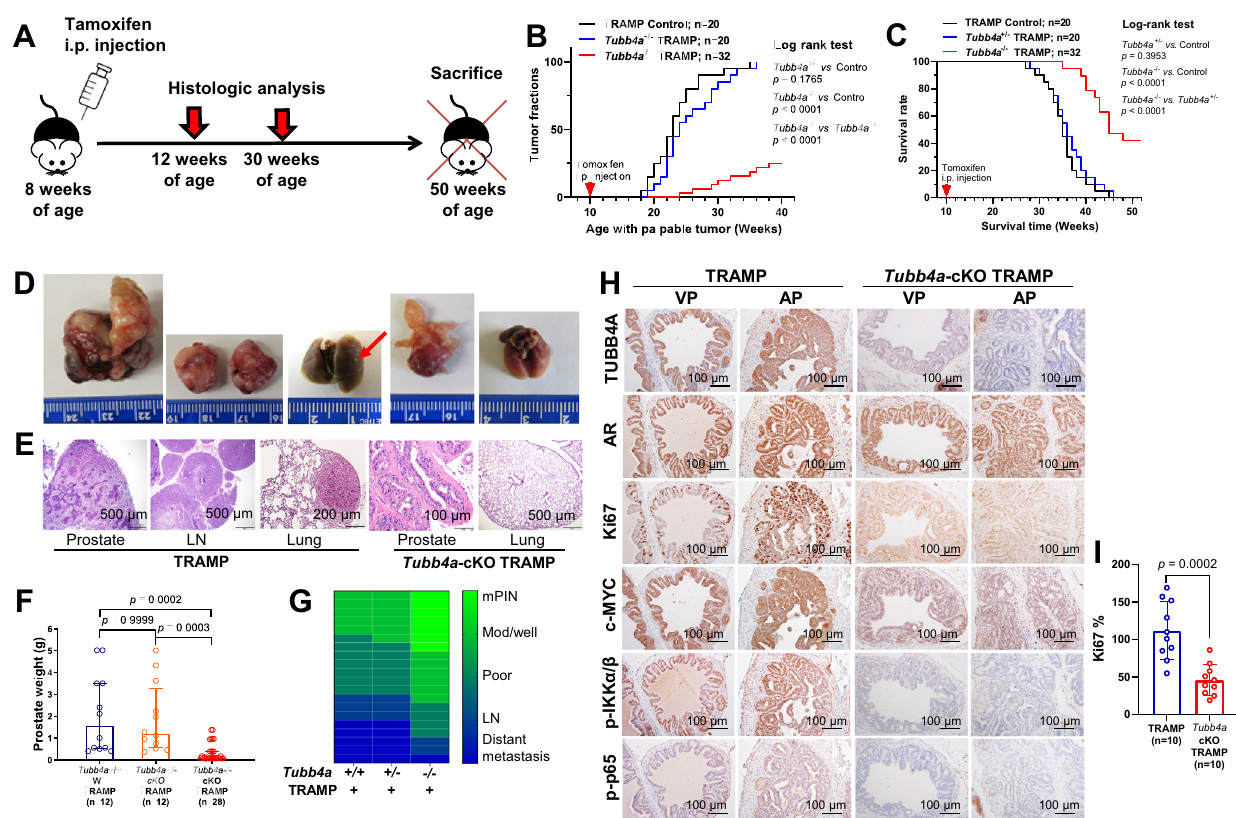
Fig. 9 Prostate-speci fi c deletions of Tubb4a and prostate tumor progression and metastasis in TRAMP models. A Schematic diagram of spontaneously developed prostate tumors followed for up to 50 weeks of age in genetically engineered mouse models. B , C Kaplan – Meier curves of palpable prostate tumors and survival for up to 40 and 50 weeks of age, respectively. D , E Representative prostate tumor growth and metastasis and H/E staining at 50 weeks of age. Scale bar, 100 μ m, 200 μ m, or 500 μ m. F Weights of prostates at 30 weeks of age. G Heatmap of prostate tumor progression and metastasis at 30 weeks of age. H Representative immunostaining for TUBB4A, AR, c-MYC, p-IKK, and p-p65 in the prostates of mice at 30 weeks of age. Scale bar, 100 µ m. I Statistical analysis of Ki67 + cells for TRAMP and Tubb4a -cKO TRAMP groups. Data are replicated 10 ( I ), 20 – 32 ( B , C ), and 12 – 28 ( F ) times. Data are presented as the medians and interquartile ranges with a Kruskal – Wallis followed by a Dunn ’ s post hoc test ( F ). Data are presented as the means and SD with a two-tailed t test ( I ). Source data are provided as a Source data fi le. AP, anterior prostate; VP, ventral prostate; cKO, prostate conditional knockout; mPIN, mouse prostatic intraepithelial neoplasia; Mod/well, moderately/well-differentiation grades; LN, lymph node; AR, androgen receptor; i.p., intraperitoneal injection; LN, lymph